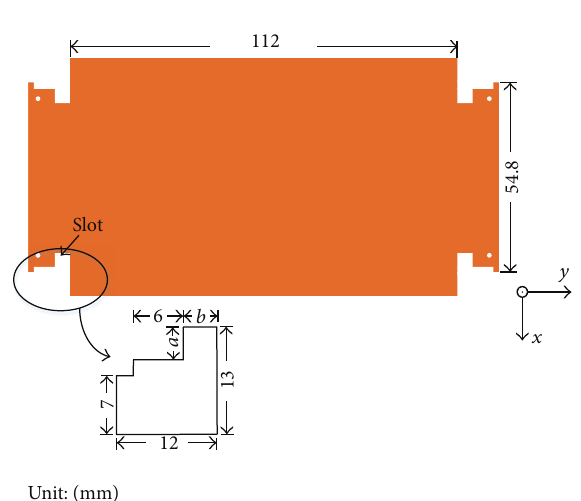
Figure 2: The MIMO antenna system.